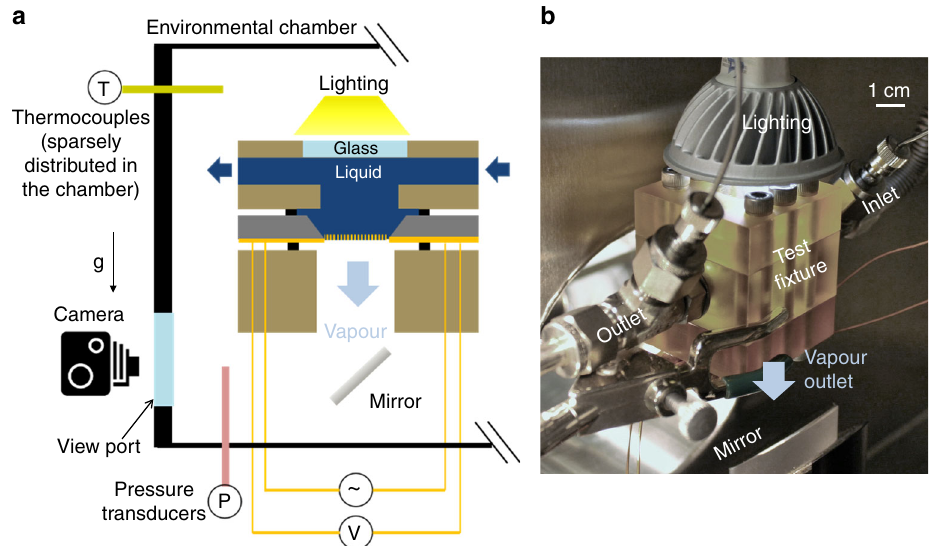
Fig. 3 Experimental setup. a Schematic of device placed in a custom test fi xture in an environmental chamber which allows for liquid feedthrough, electrical connection, and visualization (not to scale). b Image of the experimental setup